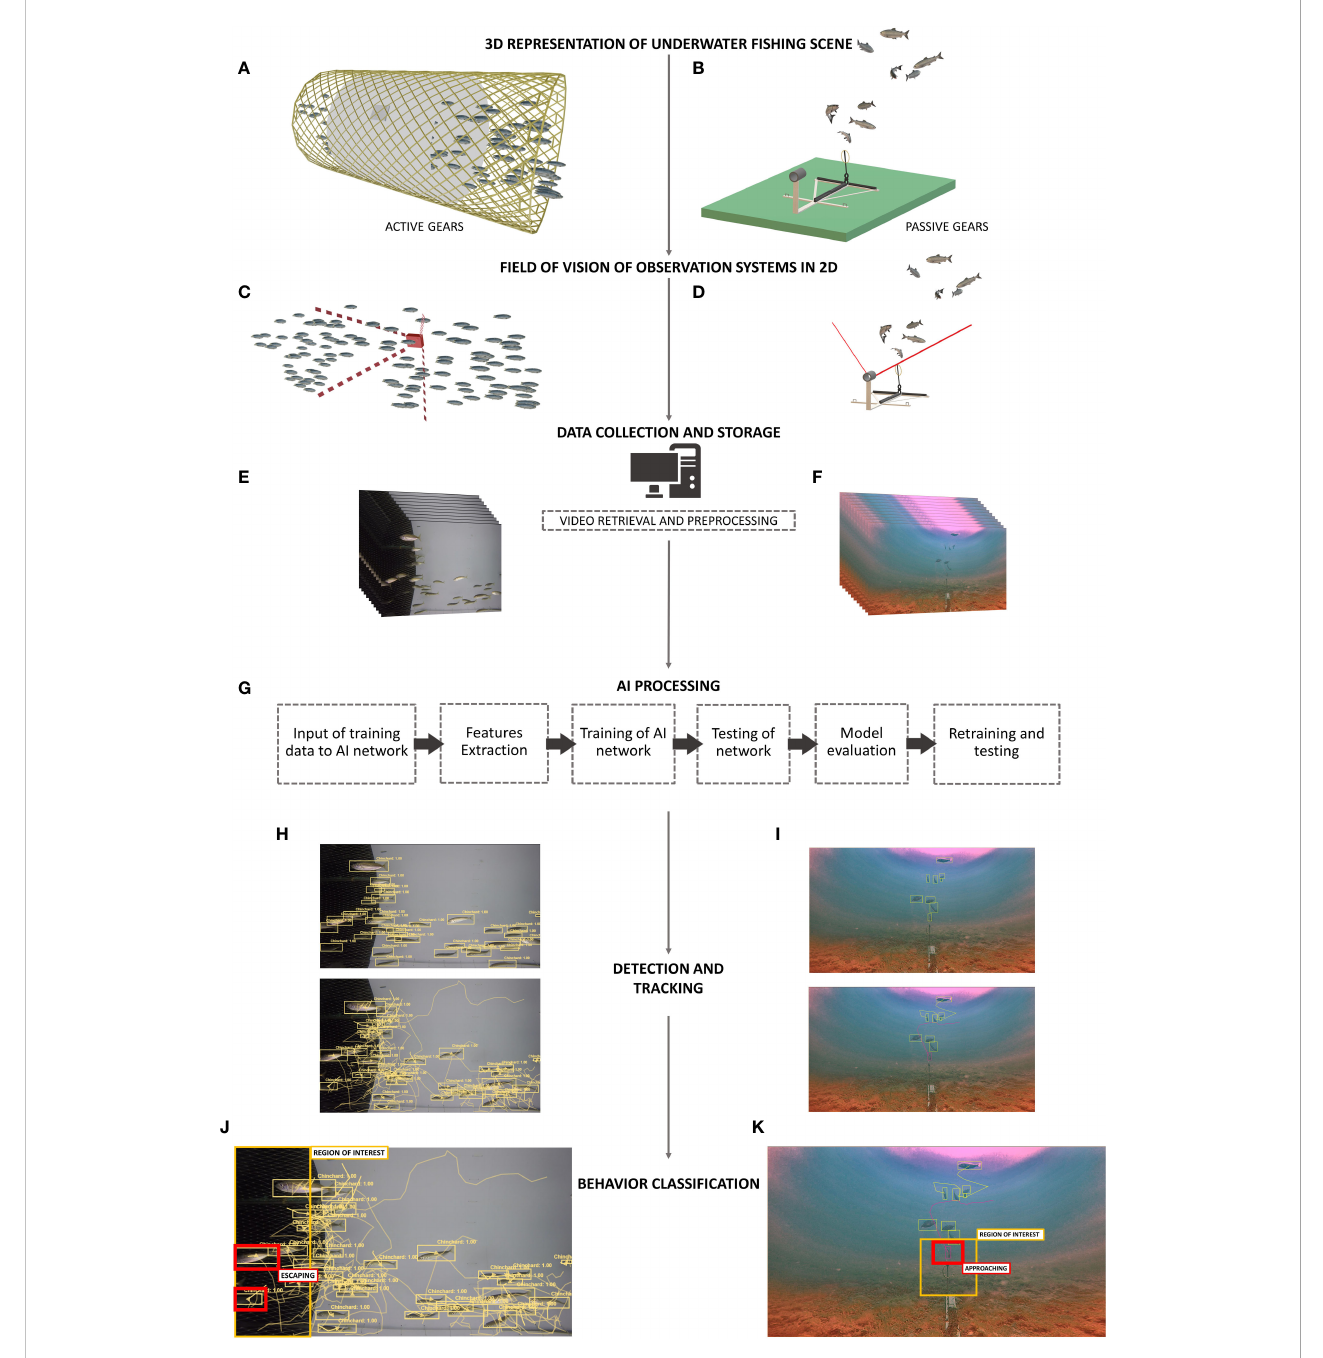
FIGURE 4 General process from in situ observations to behavior classi fi cation. (A) , Representation of a section of an active gear (i.e., pelagic net) with a white- colored material that act as a clear background for video capture. (B) , Representation of a passive gear (i.e., baited gear)-bait fi sh prototype fi xed on the sea fl oor with a remote underwater video set-up. (C) , Field of vision of a camera secured attached on one side of the pelagic net section. (D) , Field of vision of a camera facing the bait. (E, F) , Frames from video footage of the underwater observation systems. (G) , General work fl ow for deep learning model application on object detection. (H, I) , Sample of fi sh detections with bounding boxes and fi sh tracking with bounding boxes and line trails (Game of Trawls and Bait fi sh)., (J) Representation of behavior classi fi cation labels inside active gear. The “ region of interest ” labels the section of the gear near the exit and “ escaping ” labels the fi shes that are exiting. (K) , Representation of behavior classi fi cation labels with passive gear. The “ region of interest ” labels the area in proximity of the bait and “ approaching ” labels the fi sh within this proximity. 3D model of baited gear credit to BAITFISH project and image of fi shes inside the pelagic net credit to Game of Trawls